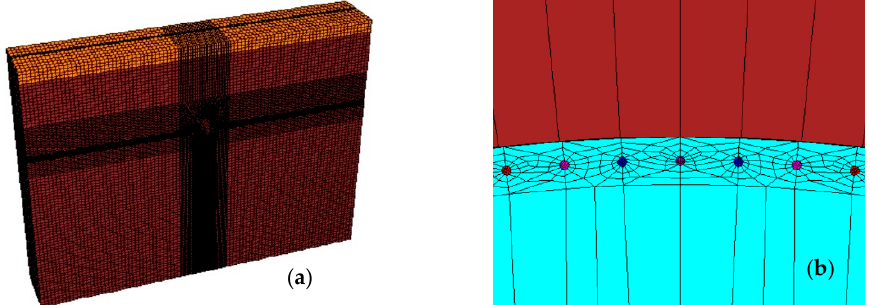
Figure 13. Layout drawing of blast holes.